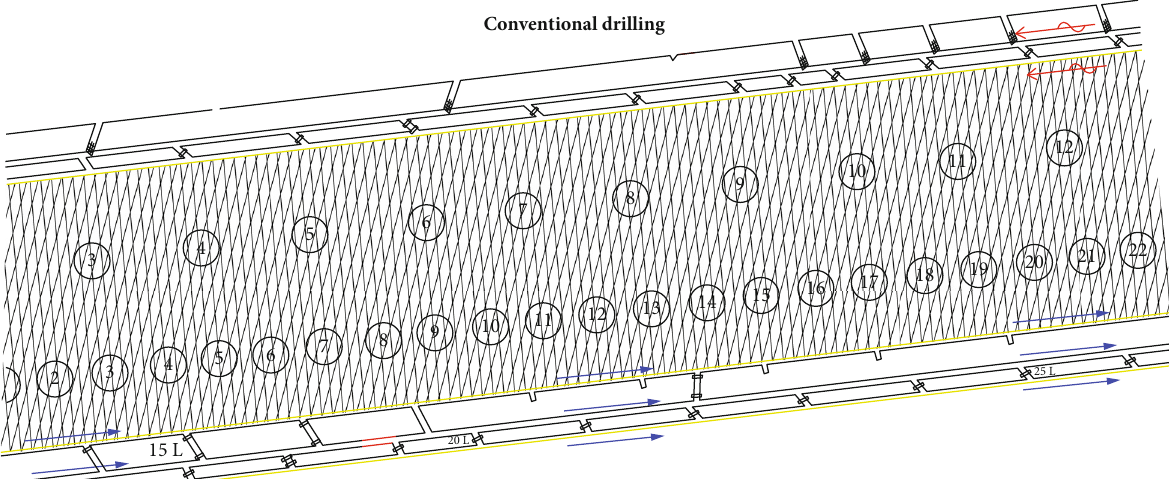
Figure 9: Conventional gas drainage from boreholes in the return air passage and glue transport